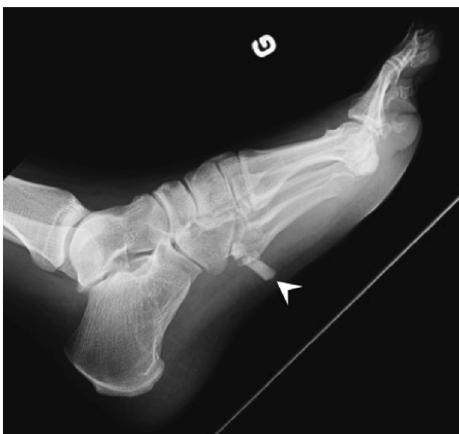
Fig. 4 Foreign bodies. Lateral radiograph of the foot shows glass fragments (arrowhead) in the plantar soft tissues, with sharp edges